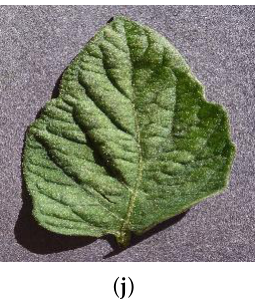
Figure 2. Sample images from the nine disease classes and the healthy one. ( a ) bacterial spot; ( b ) early blight; ( c ) late blight; ( d ) leaf mold; ( e ) mosaic virus; ( f ) septoria leaf spot; ( g ) spider mites; ( h ) target spot; ( i ) yellow leaf curl virus; ( j )